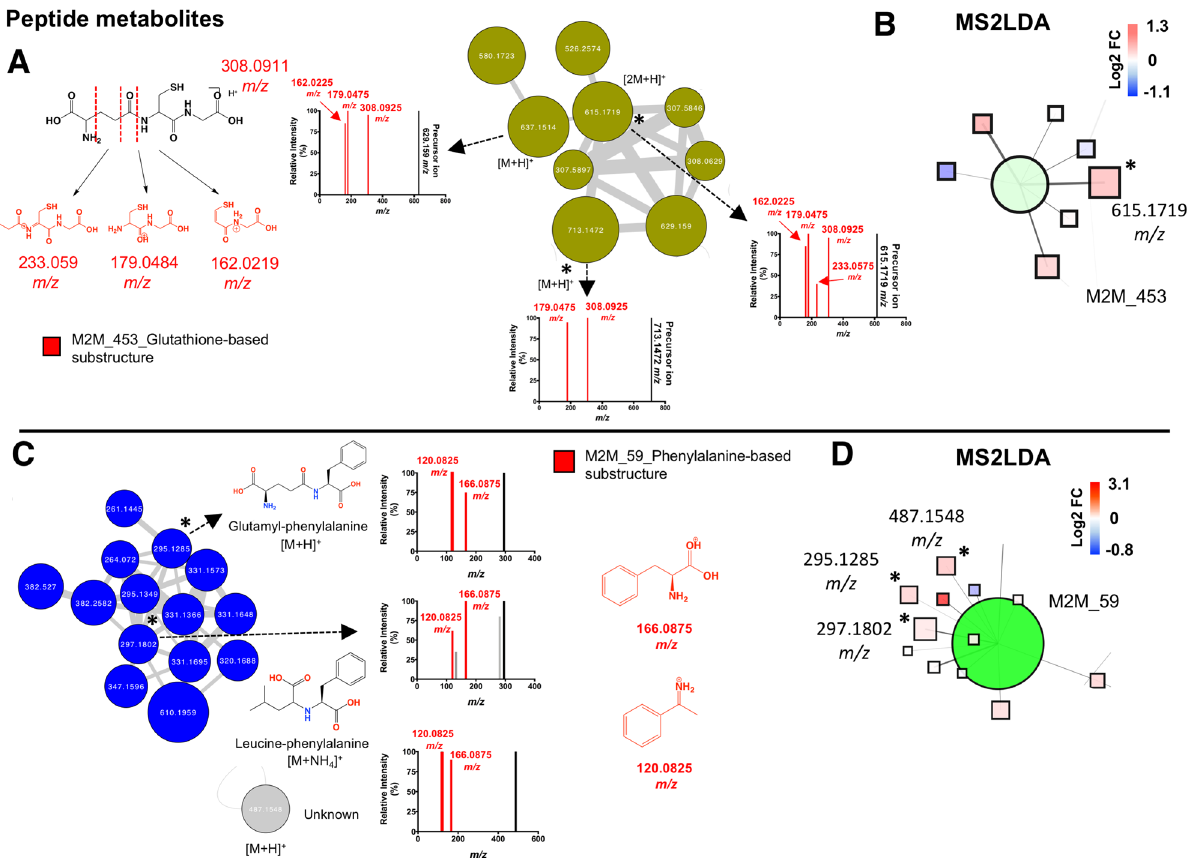
Figure 4. Peptide metabolites modulated by simulated diabetes in bovine coronary artery endothelial cells (BCAEC). ( A ) Cluster 2 retrieved from the main molecular network linked to glutathione and derivatives. The fragments of mass-2-motif (M2M)_453 colored in red are characteristic of a glutathione core and the fragments are shown in red. ( B ) Features associated with M2M_453 using MS 1 visualization in www. ms2lda. org. ( C ) Cluster 3 retrieved from the main molecular network linked to phenylalanine-based metabolites. A singular node at m/z 487.1548 is also shown. The fragments of M2M_59 colored in red are characteristic of a phenylalanine core (Heuristic and Quantum Chemical predictions by www. mzClo ud. org). ( D ) Features associated with M2M_59 using MS 1 visualization in www. ms2lda. org. In GNPS’s clusters ( A and C ), the node’s color denotes the chemical class assigned to the cluster. The thickness of the edge (connectivity) indicates the cosine score (MS 2 similarity). The m/z value of the feature is shown inside the node and is proportional to the size of the node. Significant differential abundant features among simulated diabetes (HG + HI) and control (NG) groups are indicated with an asterisk ( p value < 0.05). In MS2LDA’s nodes ( B and D ), the green node represents the M2M and squares indicate individual features. Edges represent connections to M2M. Significant differential abundant features among groups are indicated with an asterisk ( p value < 0.05). Abbreviations: M2M mass2motif, FC fold change, NG normal glucose, HG high glucose, HI high insulin. Chemical structures were drawn by ChemDraw Professional version